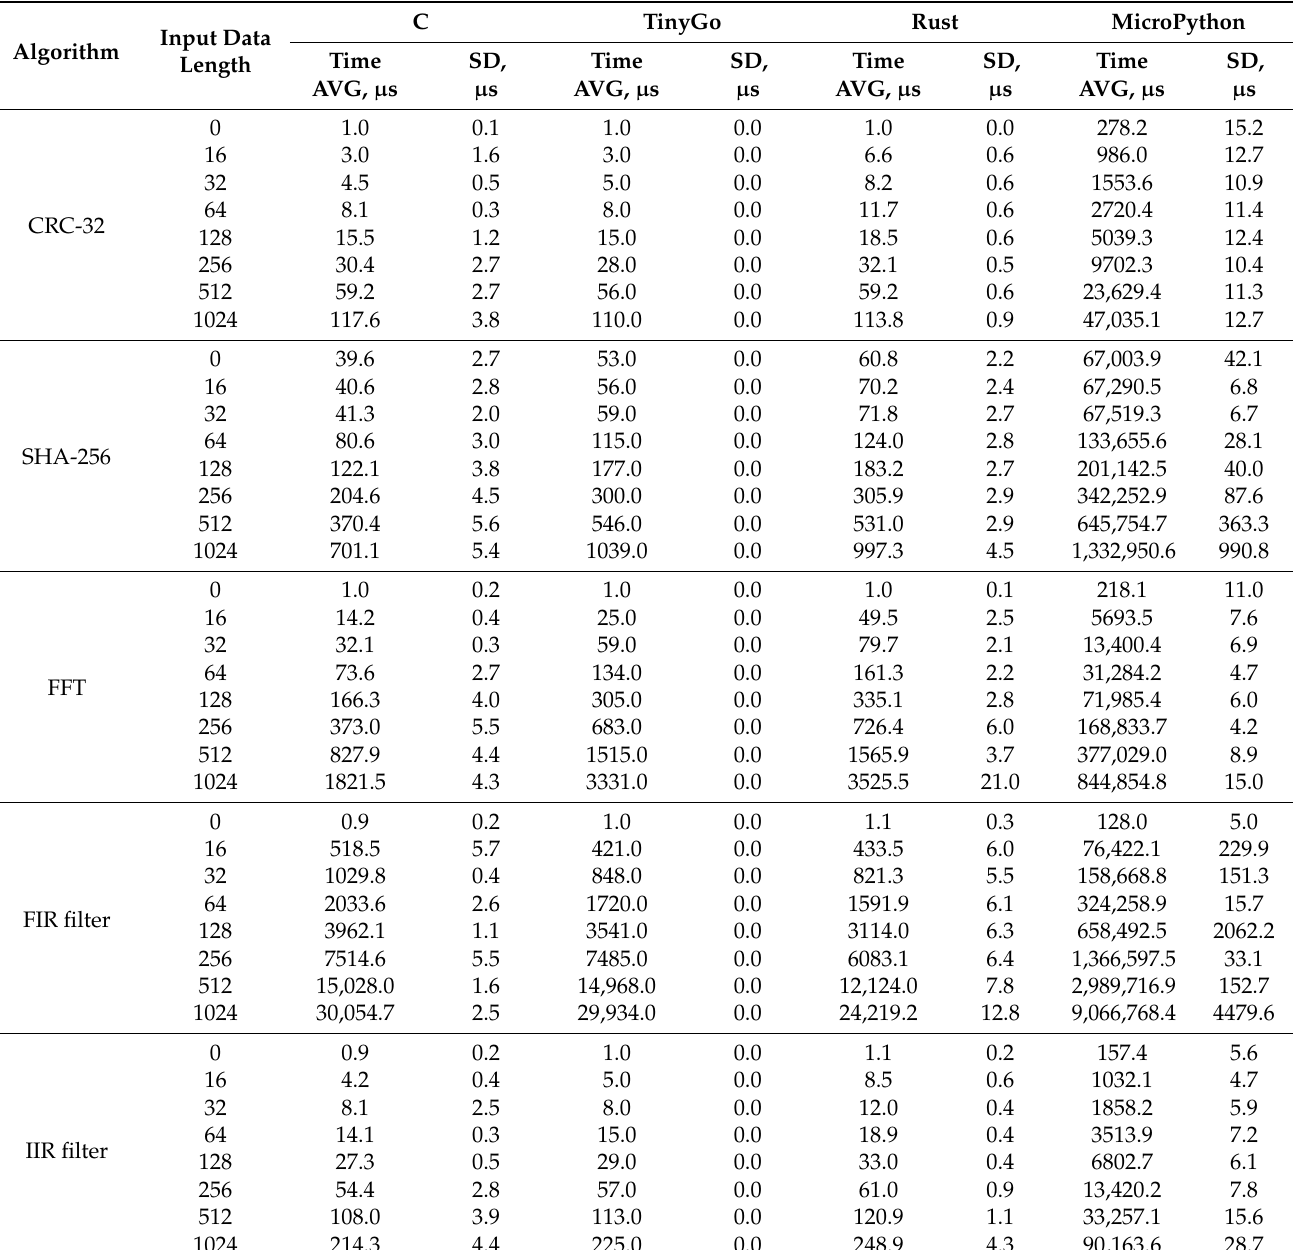
Table 5. Average execution times and standard deviations of the algorithms compared (Time AVG— average execution time, SD—standard